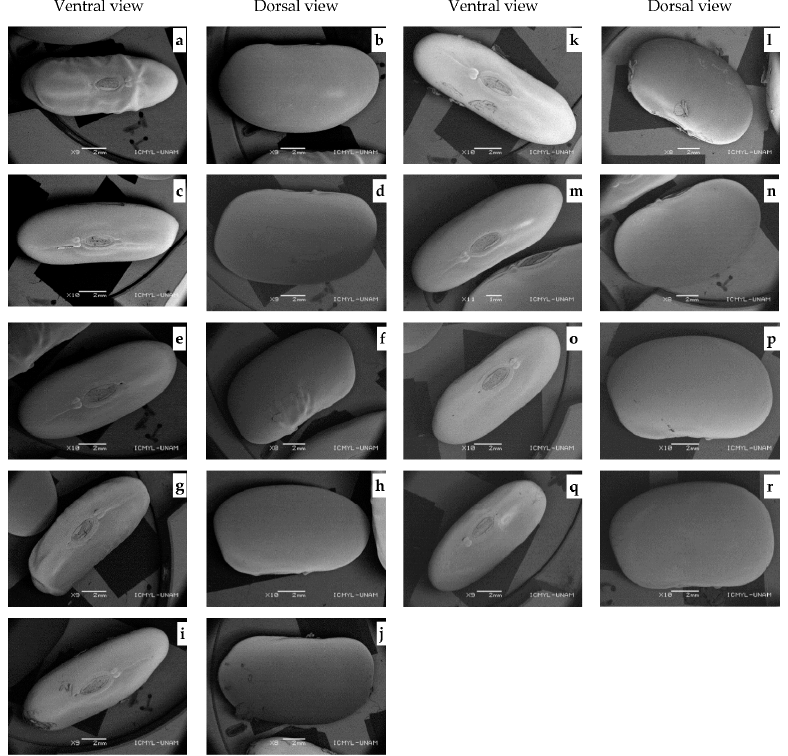
Figure 2. Micrographs of bean seeds obtained by SEM, where ( a , b ) W; ( c , d ) CS0.1; ( e , f ) CS0.5; ( g , h ) CS1; ( i , j ) CSD; ( k , l ) CDA; ( m , n ) CD119; ( o , p ) CD071 and ( q , r ) A. 3.2. Germination Capacity and Germination Speed In the germination test for bean seeds, all the treatments were superior to the control; CS0.1, CS0.5 and CD119 treatments showed a 26% increase in germination; CS1 and CDA treatments were superior by 18 and 16%, respectively, and the CD071, CSD, CDA and A treatments were higher by 12% compared with the control (Figure 3A). On the other hand, for sesame seeds, the best treatments compared with the control were CS0.1, CS0.5 and CD119 with an increase of up to 16% in the germination percentage; CS1, CD071, CSD, CDA and A treatments showed a similar germination to the control (Figure 3B).